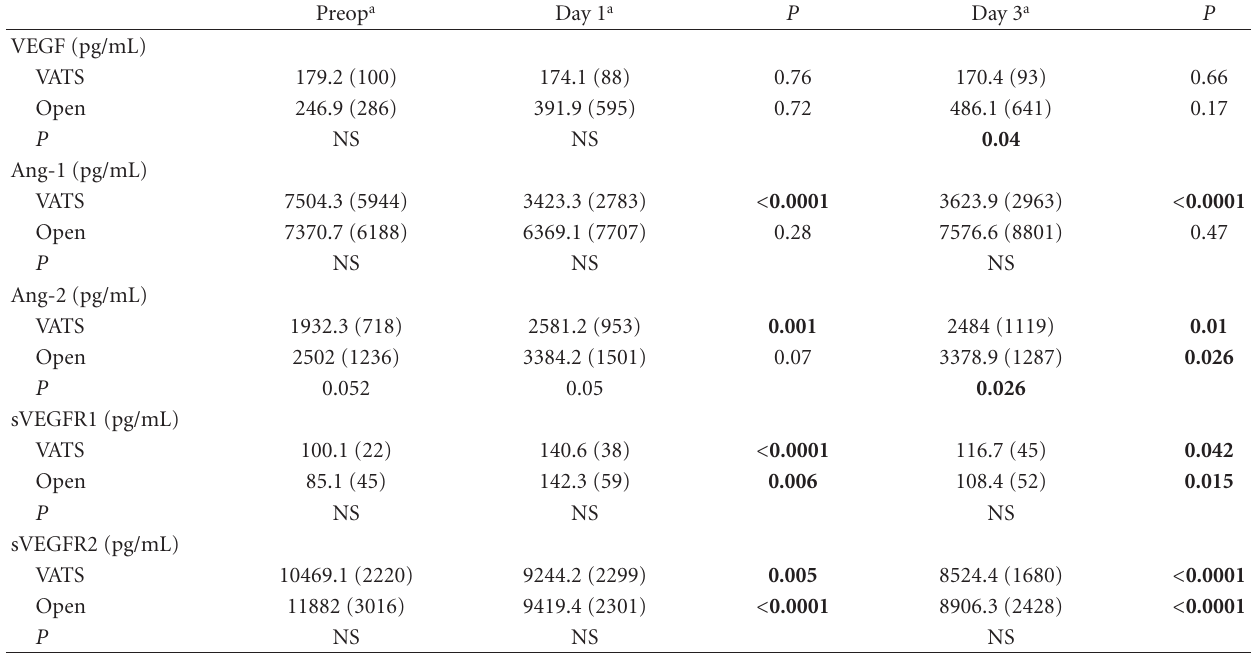
Table 2: VEGF, Ang-1, Ang-2, sVEGFR1 and sVEGFR2 levels after VATS and open lung